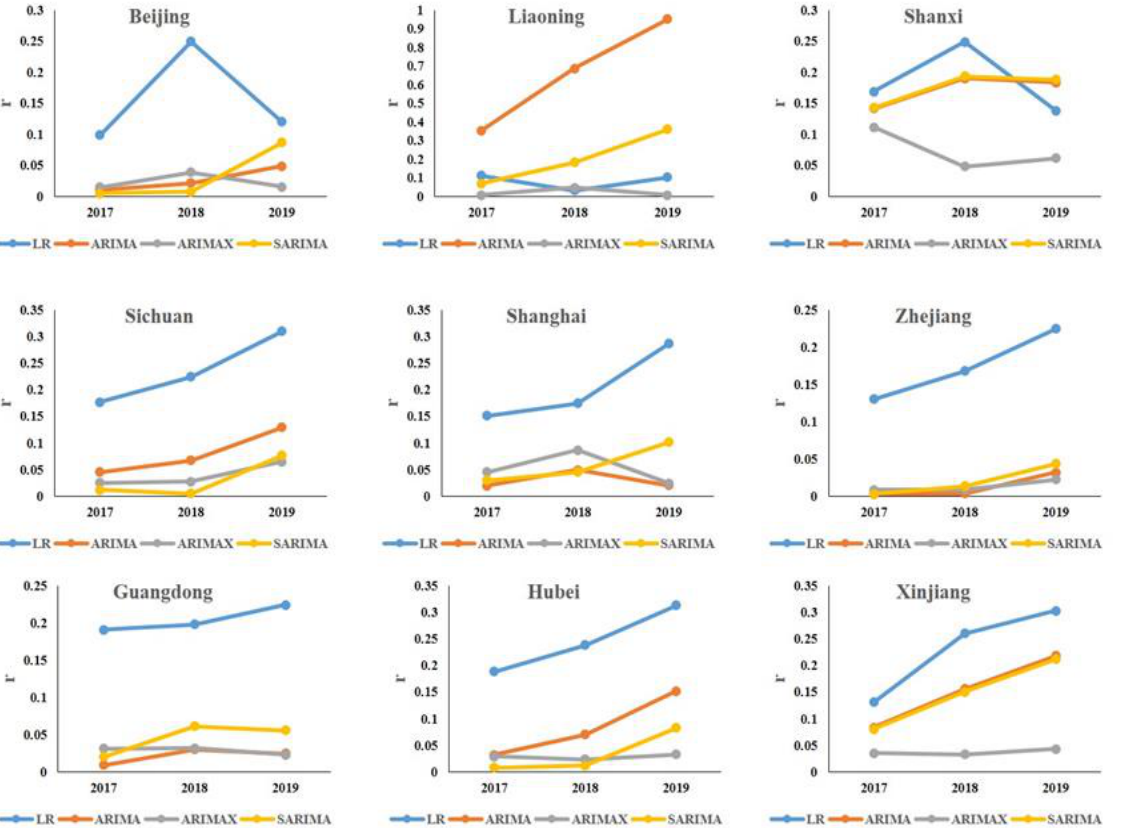
Figure 9. The r of different GDP forecasting models in selected Chinese provinces.